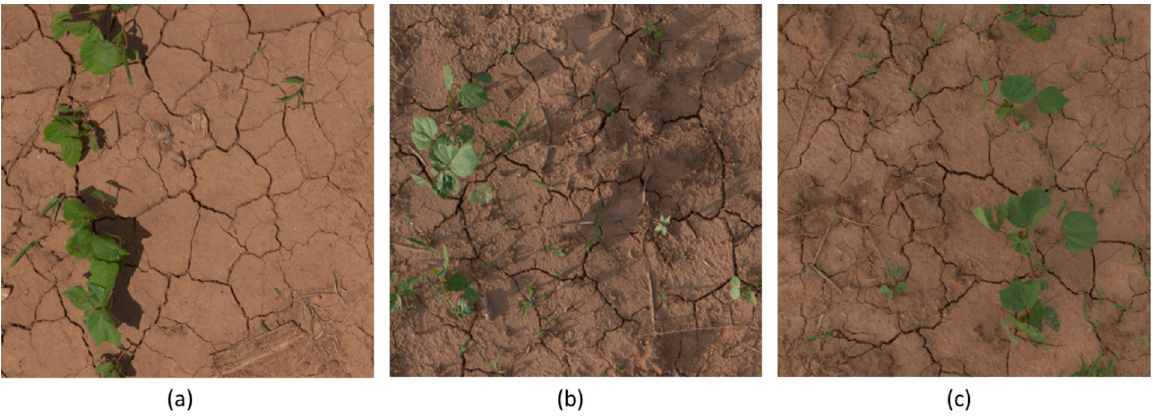
× 2048 in S noon ( a ), S sunset ( b ), and S